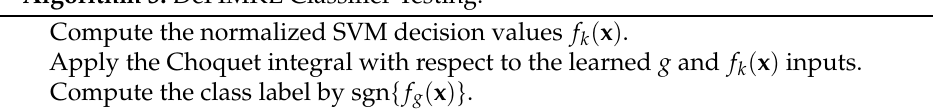
Algorithm 3: DeFIMKL Classifier